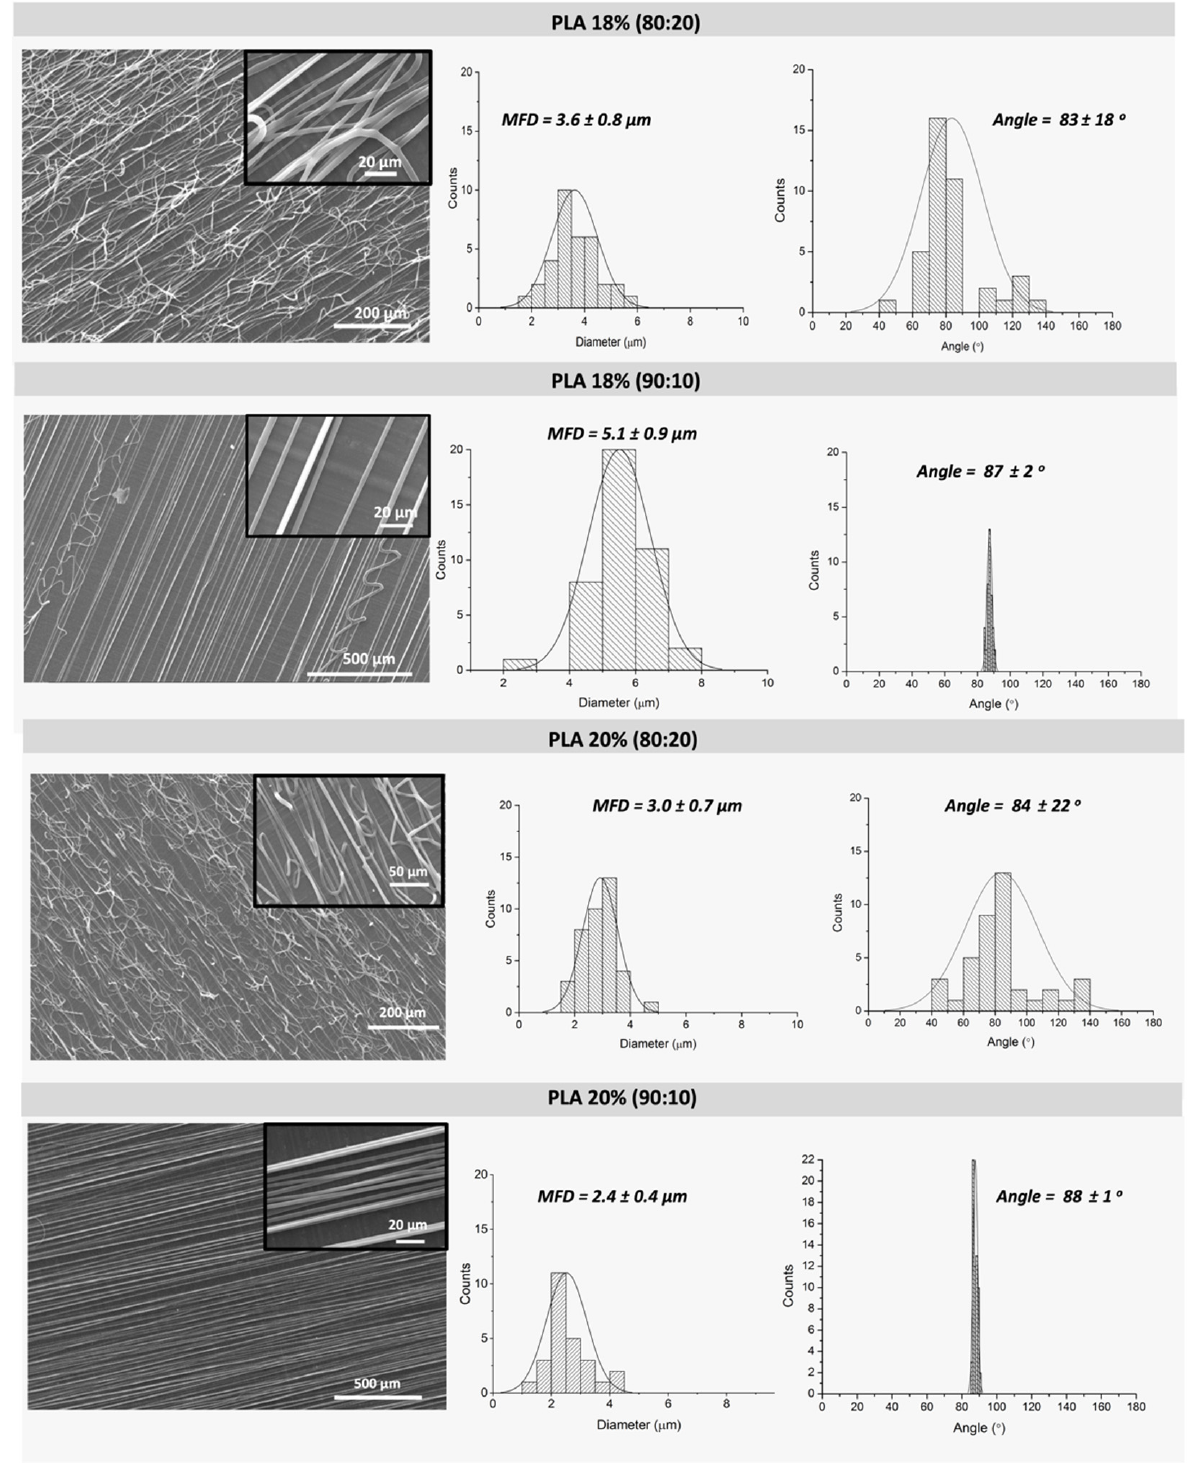
Figure 3. SEM micrographs corresponding to PLA fibers obtained with different PLA concentrations of 18 and 20 wt.% and CHCl 3 :DMF with different ratios 80:20 and 90:10, with their corresponding histograms to determine mean fiber diameter (MFD) and orientation. (Electrospinning fixed parameters: 16 kV, needle-to-collector distance 12 cm, feeding rate of 1.0 mL/h and rotor velocity of 1300 rpm).